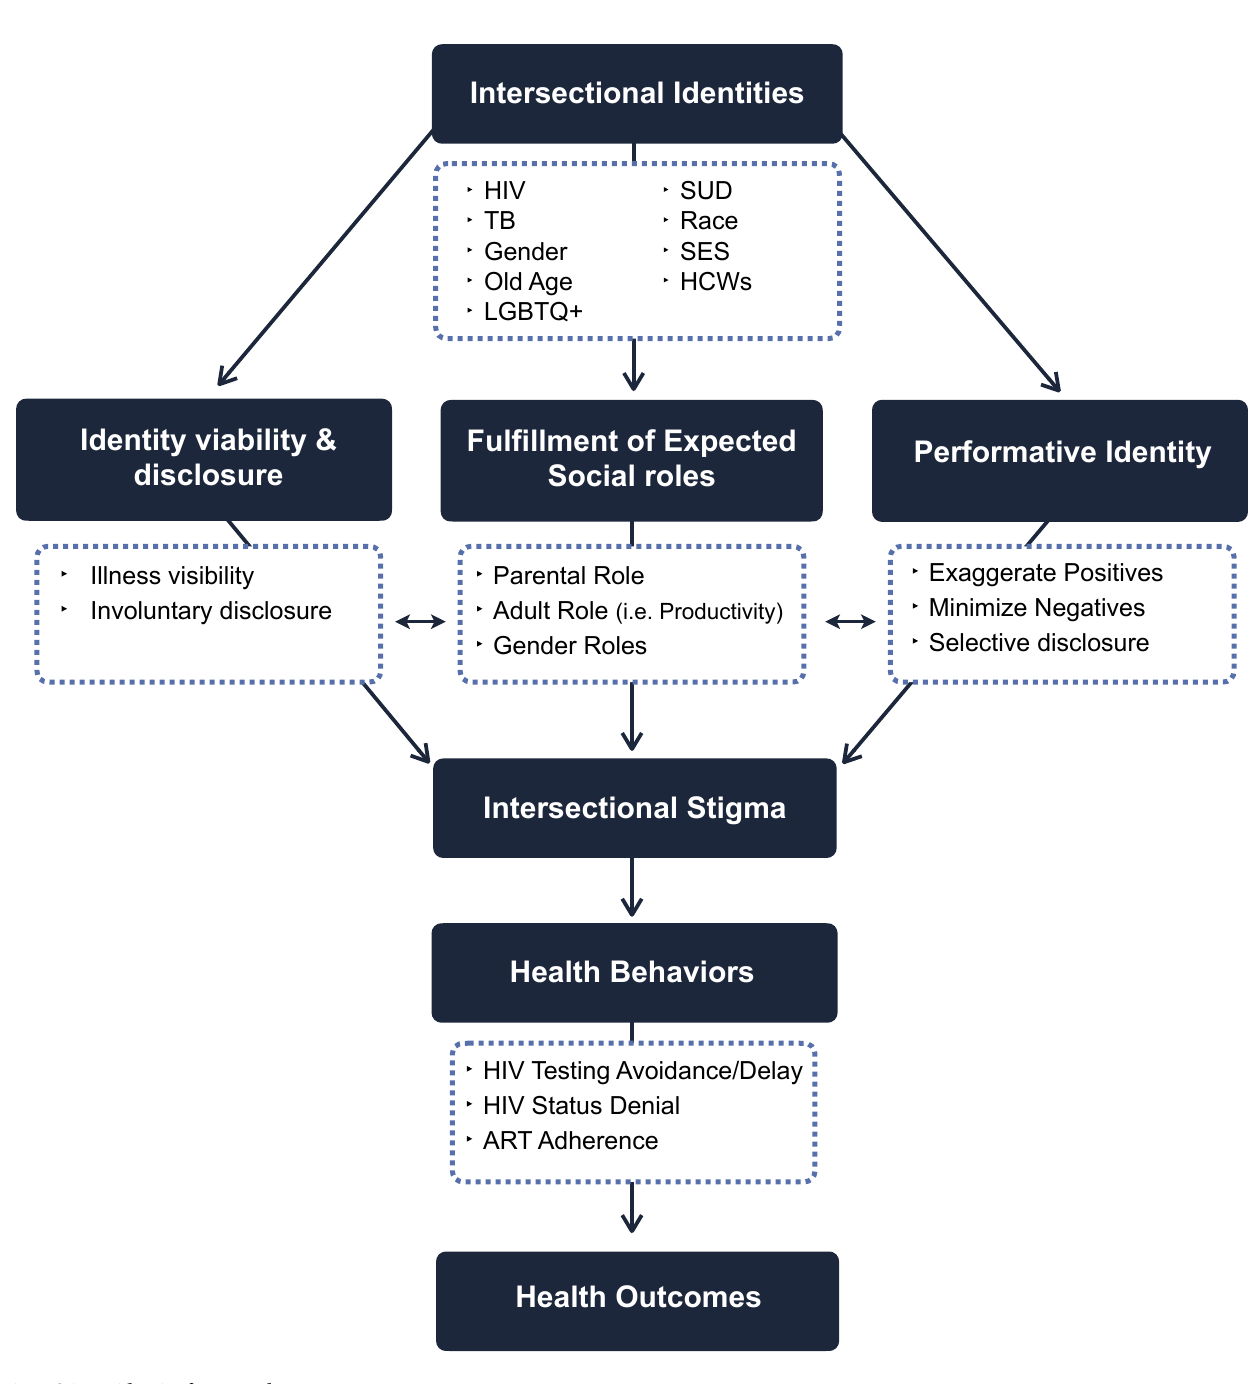
Fig 2. Stigma identity